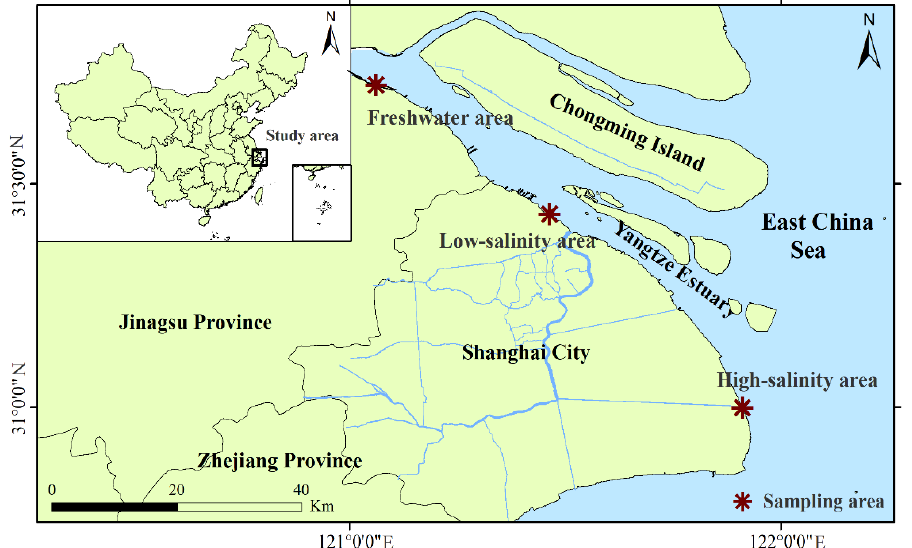
Figure 1. The geographical location of the Yangtze Estuary and sampling locations.